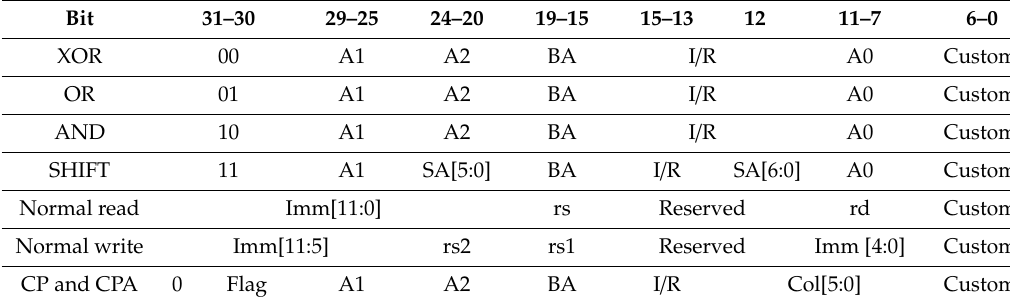
Table 3. IMC-adapted instruction definition list.